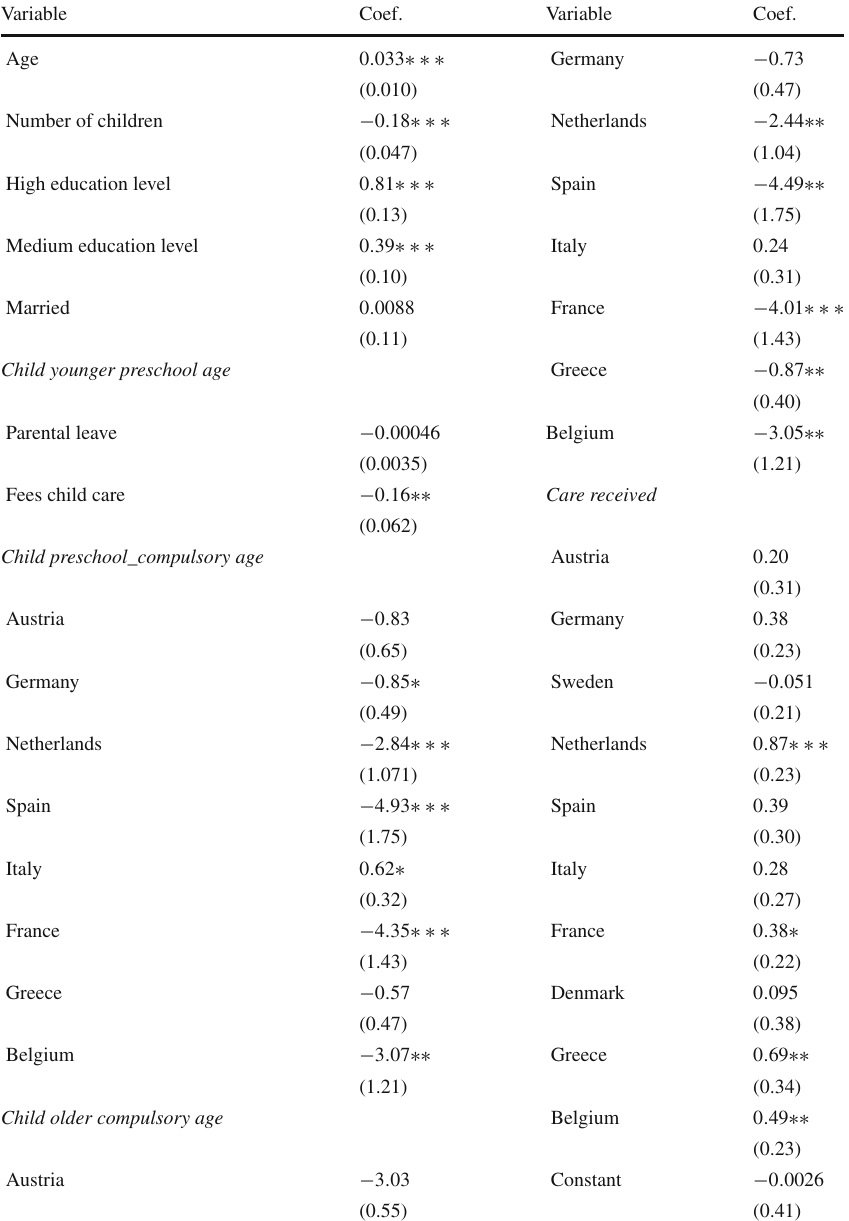
Table 7 Probit estimates of the labor participation decision of the daughter Variable Coef. Variable